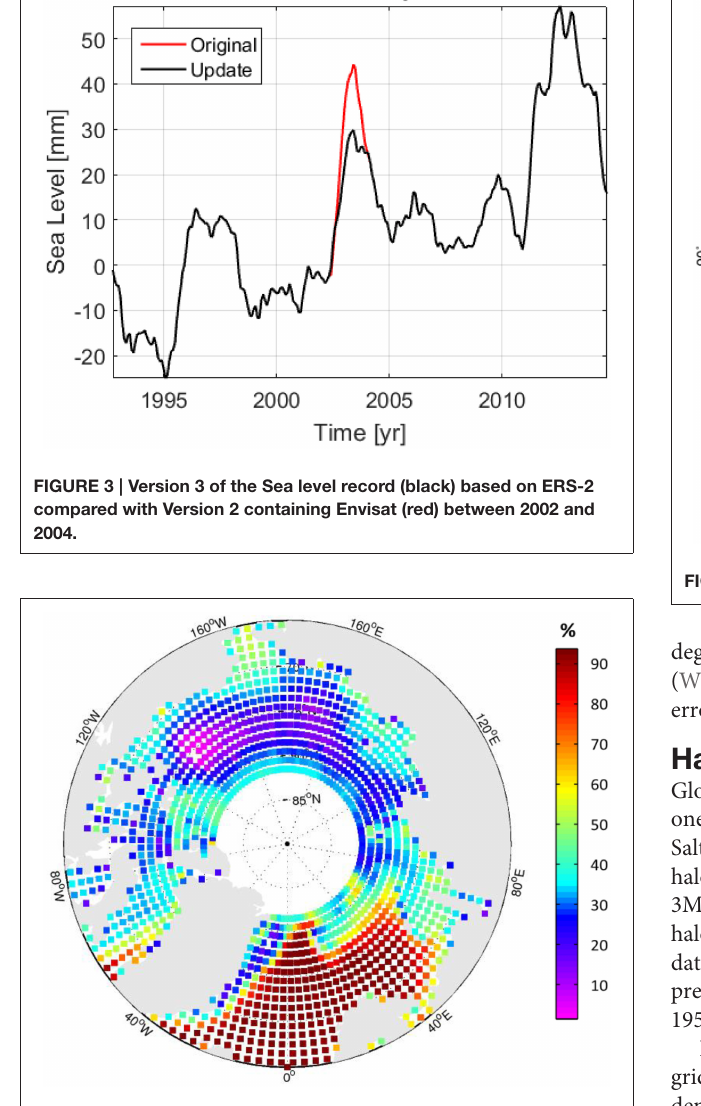
FIGURE 4 | Percentage of weekly altimetric observations (b).